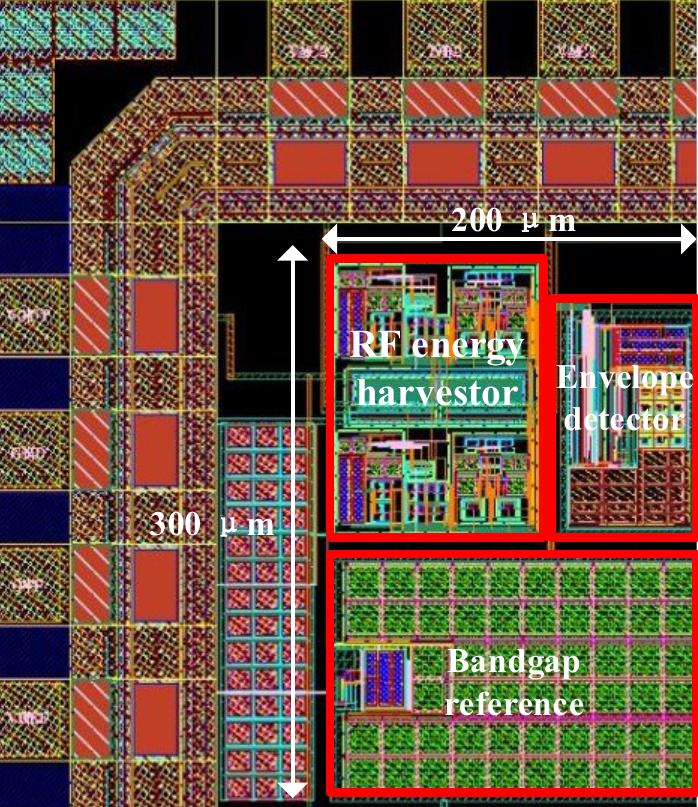
Figure 14. Layout of proposed batteryless envelope detector with RF energy harvesting